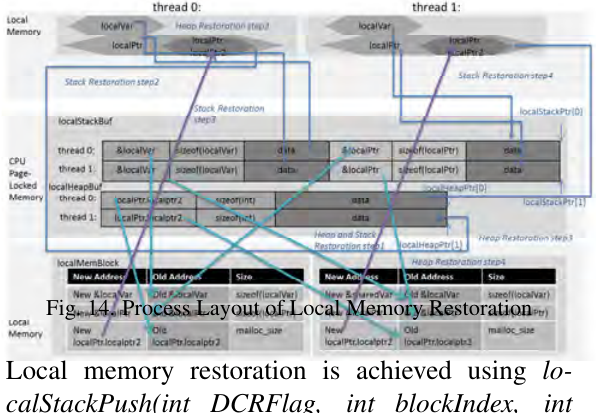
Fig. 14. Process Layout of Local Memory